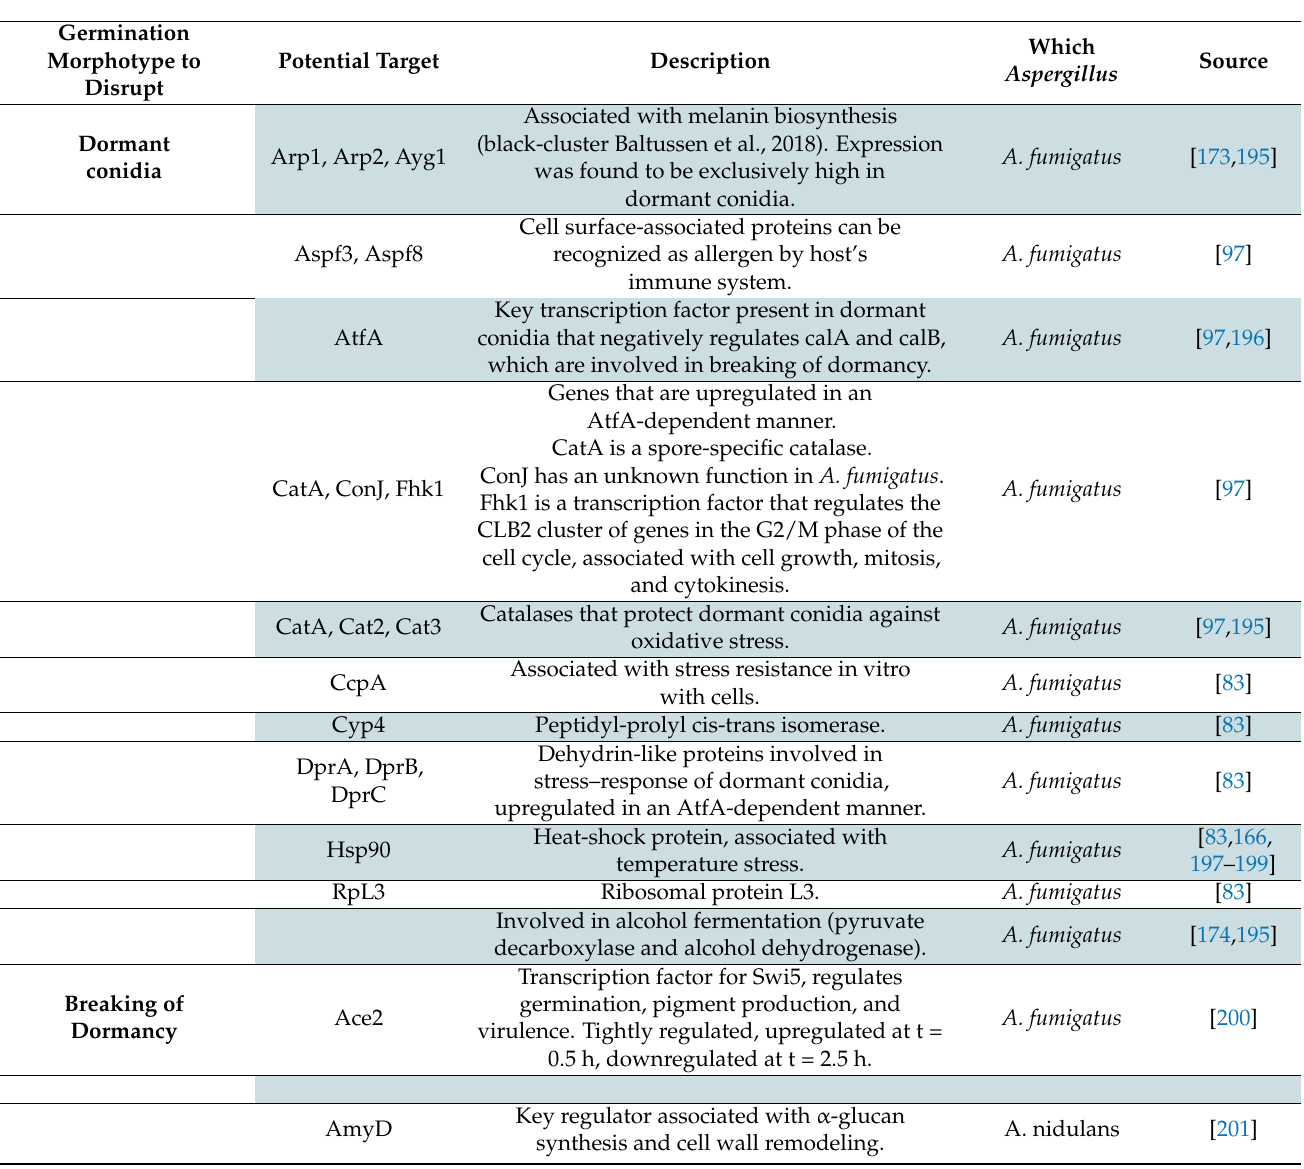
Table 2. Potential targets to disrupt the specific morphotypes of germination of Aspergillus